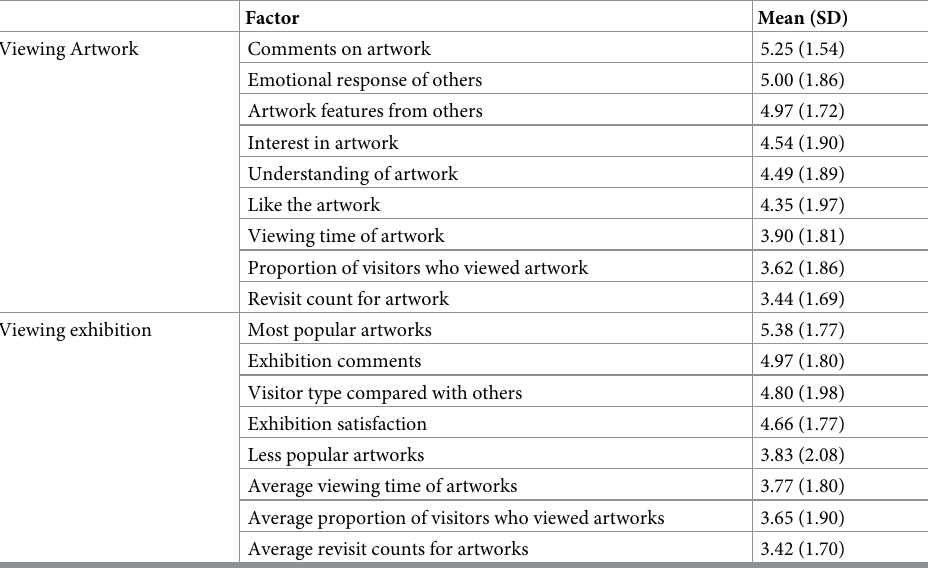
Table 2. Results of the ratings of participants on the elements of visitor-based social contextual information. Factor Mean (SD) Viewing